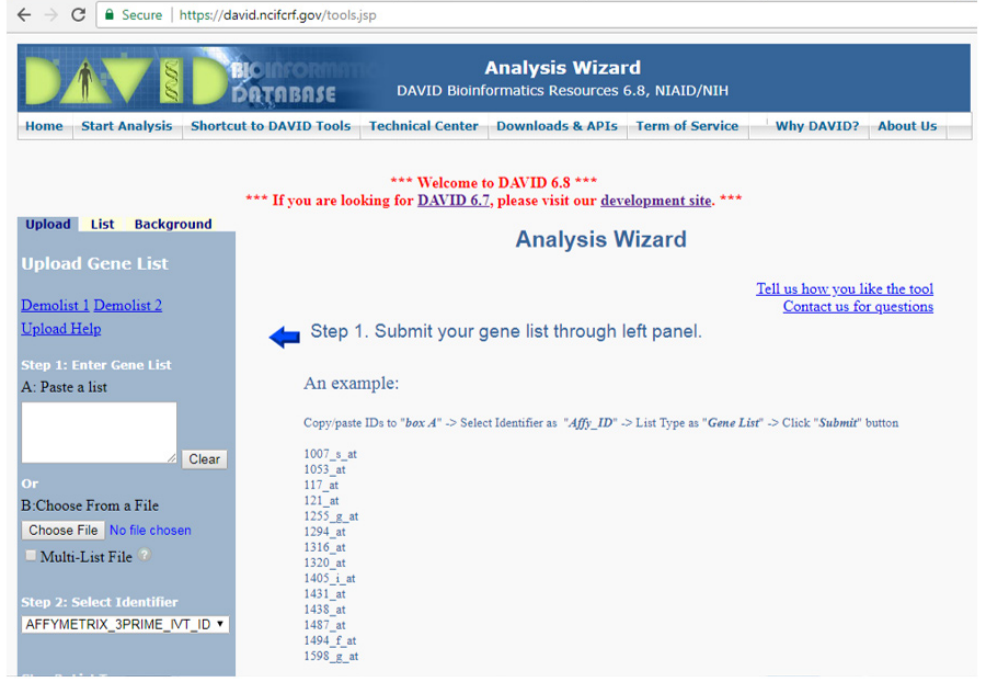
Figure 3. Submitting a geneset. Screenshot of the page where a geneset can be submitted “Step1: Enter Gene List”, there are options to copy and paste a geneset or upload a file. There is also an option to use either of two sample lists provided by the DAVID site. Under the pull down menu, “Step 2 Select Identifier”, there are many types of identification designations for the same gene. For the sample lists, the identifier and species will be recognized automatically. When submitting a gene list from the geneset generator, the identifier is “Official Gene Symbol” which is used in most cases. If the identifier that you choose does not match the identifiers in the submitted gene set, you will receive a message stating this and an option to convert to the correct